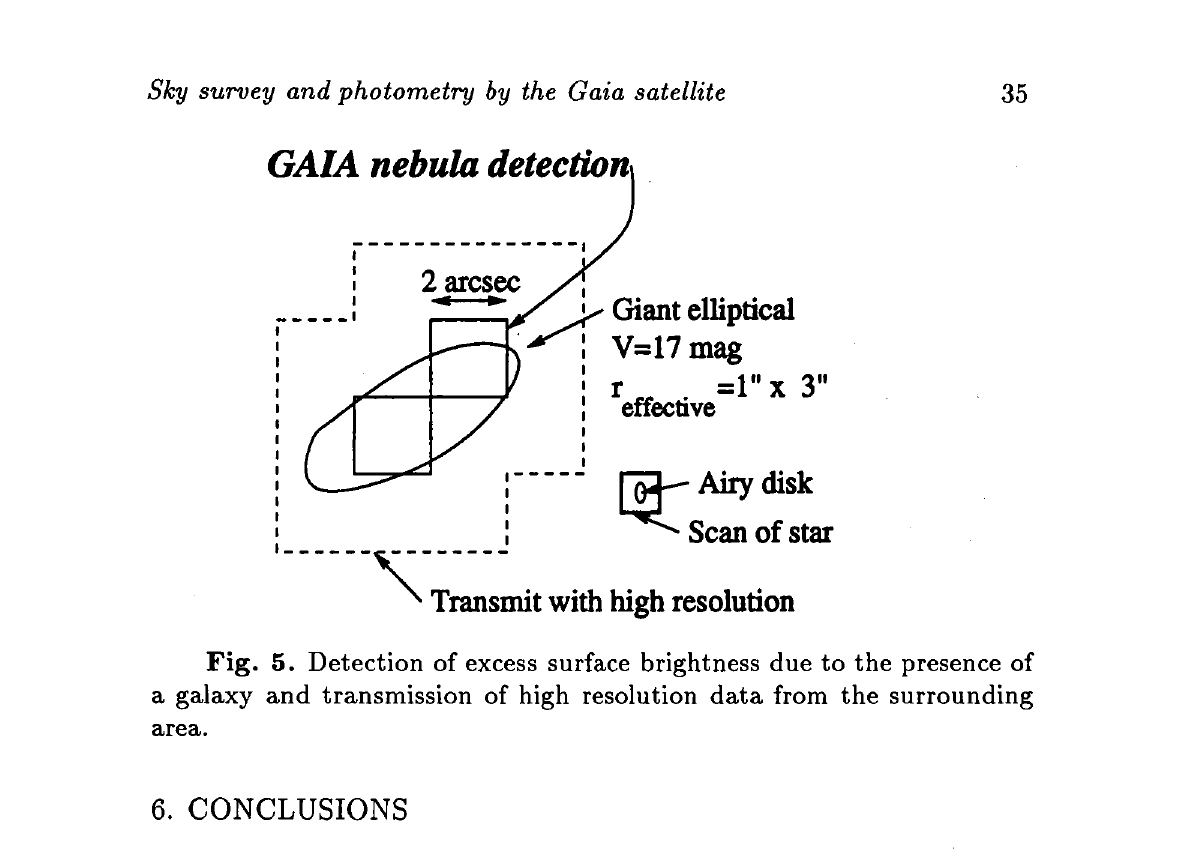
Fig. 5. Detection of excess surface brightness due to the presence of a galaxy and transmission of high resolution data from the surrounding